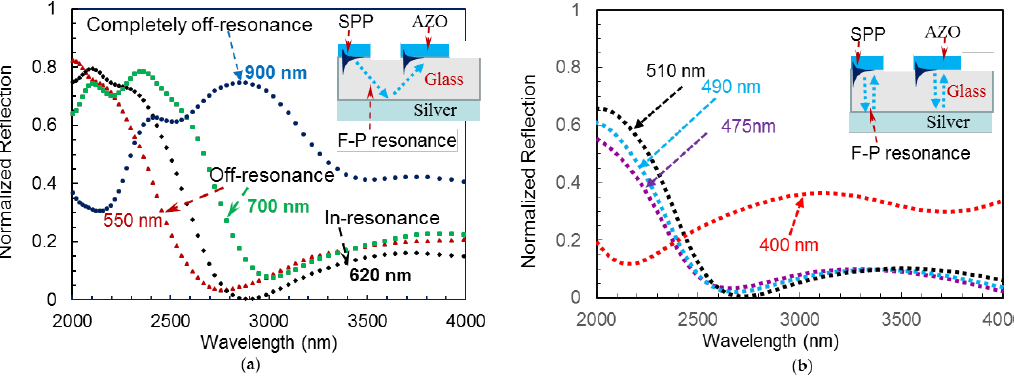
Figure 2. ( a ) Simulated reflection spectra from a stack of AZO hole arrays/spacer/silver for a spacer thickness of 550, 620, 700 and 900 nm. Total light absorption (TLA) is achieved when a surface plasmon polariton (SPP) couples with the F-P resonance in zig-zag fashion, as shown in the inset; ( b ) Simulated reflection spectra for a spacer thickness of 475, 490, and 510 nm. The coupling of SPP with F-P resonance occurs at a shorter cavity length than in the case in ( a ), as shown in the insert. When the thickness is decreased to 400 nm, off-resonance appears.